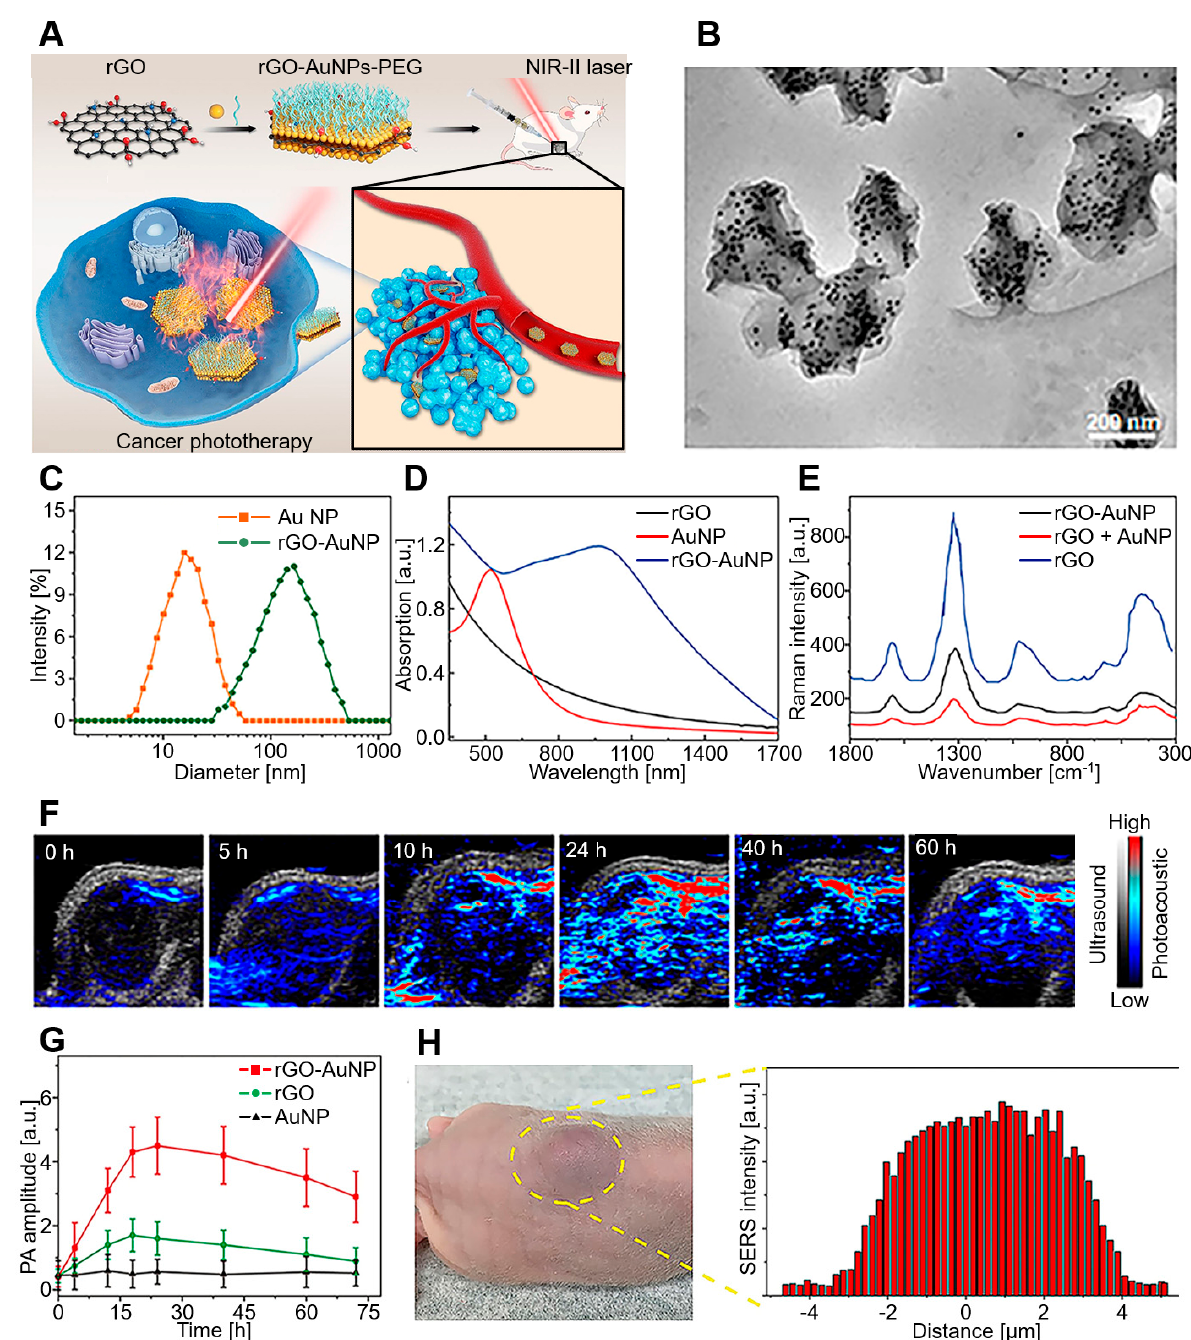
Figure 6. rGO–AuNP–PEG for PAI in the NIR-II window. ( A ) Schematic diagram of rGO–AuNP– PEG synthesis and PAI-guided PTT for cancer ablation in the NIR-II window. ( B ) TEM images, ( C ) hydrodynamic distribution, ( D ) UV–vis spectra, and ( E ) SERS spectra of rGO–AuNPs. ( F ) PA images and ( G ) PA amplitude after 1250 nm laser irradiation. ( H ) In vivo SERS signal of the tumor and its surrounding tissues to determine the boundary between tumor and normal tissue. The images are reproduced with permission from ref. [105].